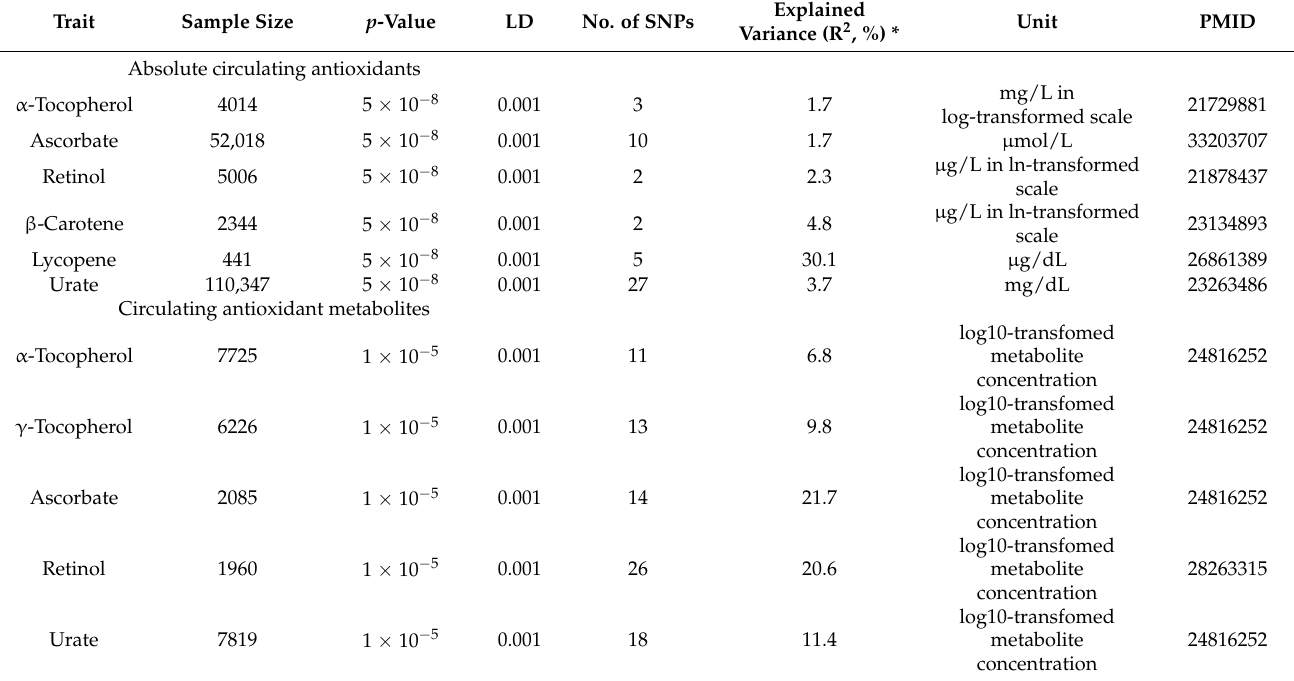
Table 1. The summary of instrumental variables for diet-derived absolute circulating antioxidants and antioxidant